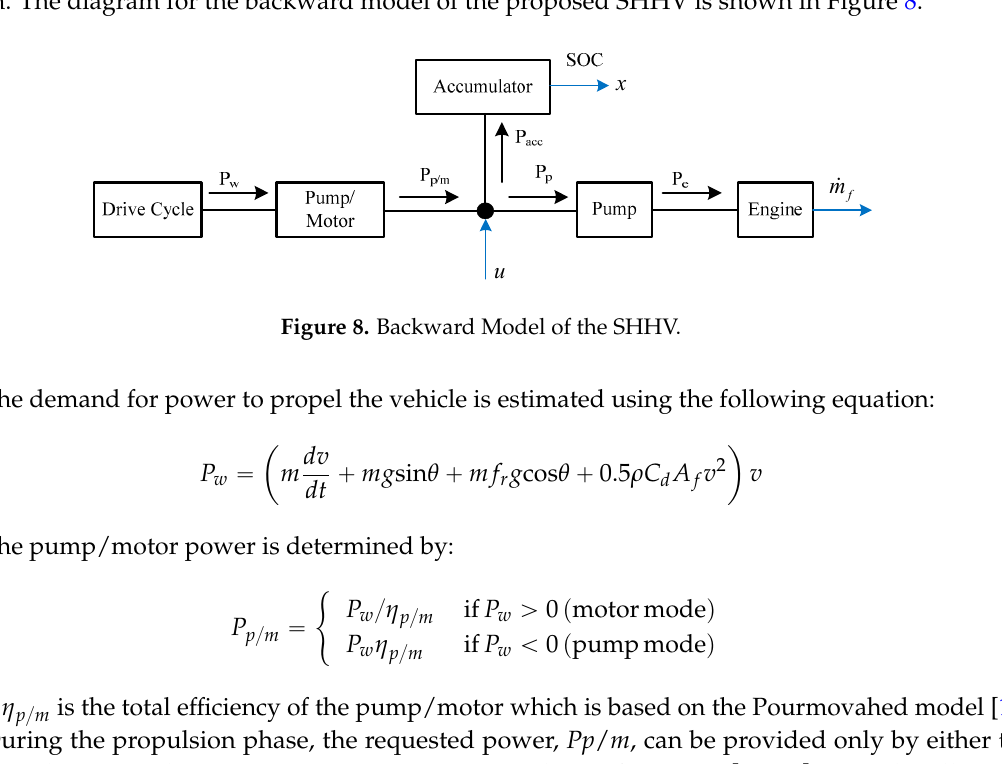
j k u Figure 7. State and Control Input Discretization in Time and Space. Based on the principle of optimality, the calculation of the DP can be done in reverse following algorithm: At k = N , if there is no constraint on the final state,   0 N